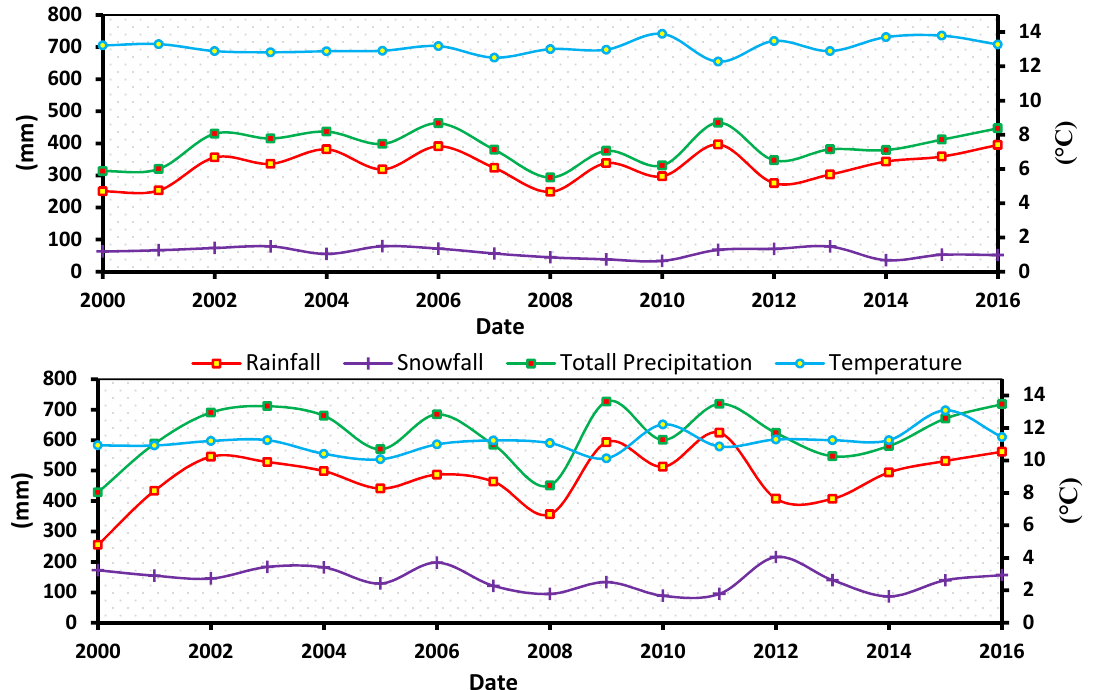
Figure 13. Mean annual time series of snowfall, rainfall, air temperature, and total precipitation in the LU basin ( top ) and the LV basin ( bottom ).